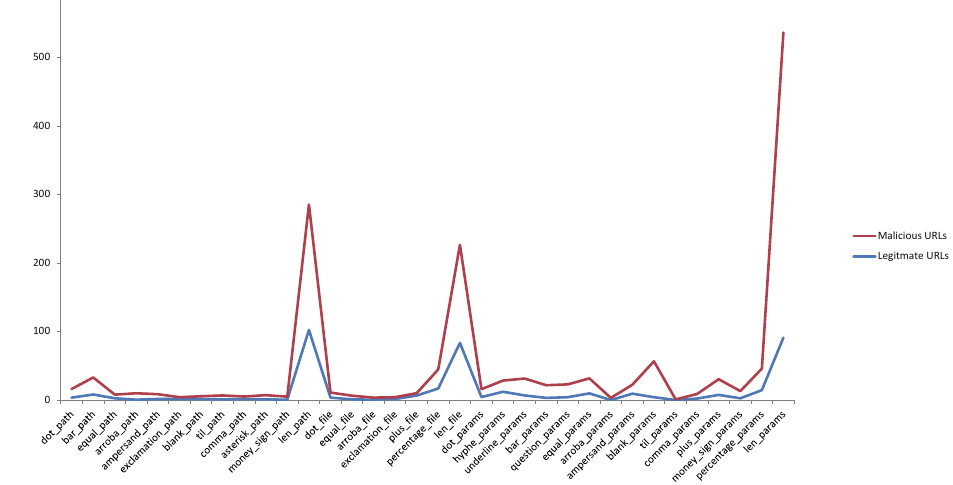
Figure 9. Distribution of URL hand-crafted features in our